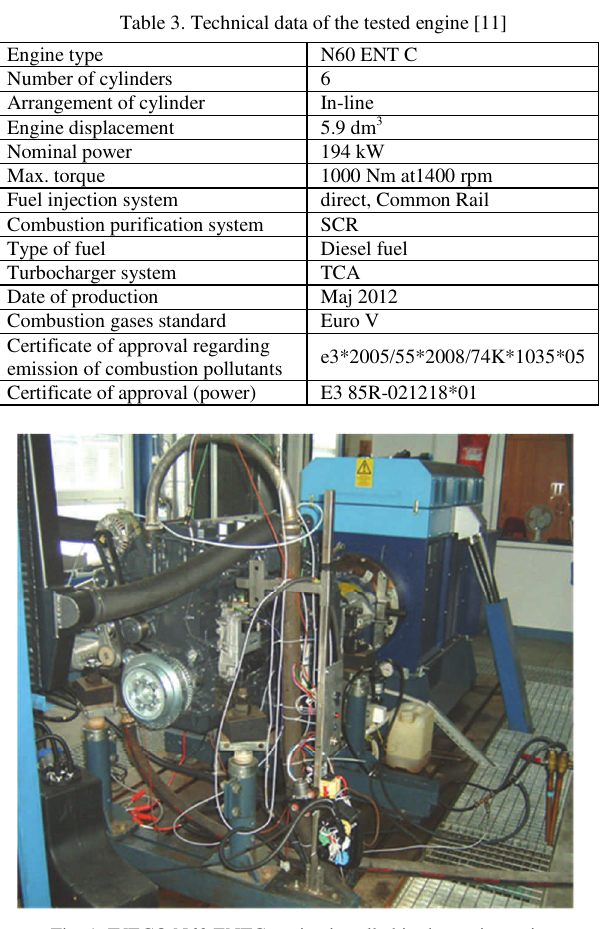
Fig. 1. IVECO N60 ENTC engine installed in the testing unit